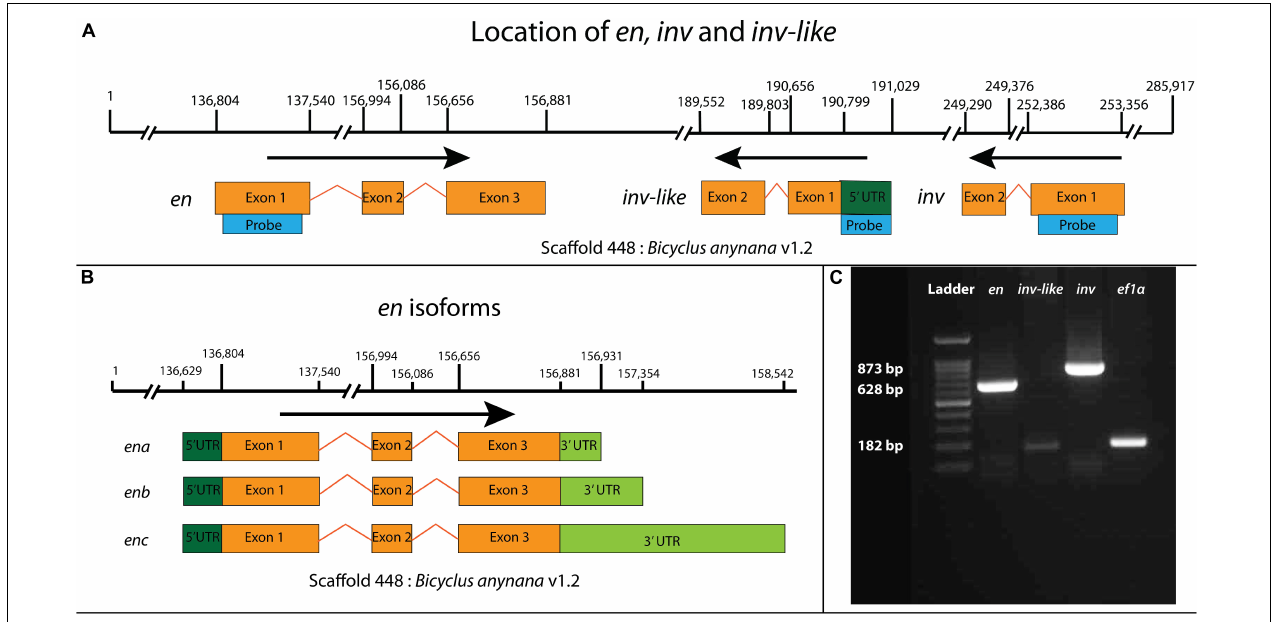
FIGURE 1 | Mapping of engrailed ( en ) family genes in the genome of B. anynana, en isoforms, and RT-PCR based verification of the three copies. (A) Three en -like paralogs are present in the genome of B. anynana . All three copies are present close to each other in scaffold 448 of Bicyclus anynana v1.2 genome assembly (Nowell et al., 2017). Blue bars indicate sequences specific to each of the copies that were used for designing probes for in situ hybridization. (B) Isoforms of en . Three isoforms of en are present in the scaffold 448. (C) RT-PCR based verification of en , inv-like, and inv in the pupal wings of B. anynana . Ef1 α was used as a positive control. The probe for exon 1 of inv is absent in inv-like and hence the chance of cross-reactivity is